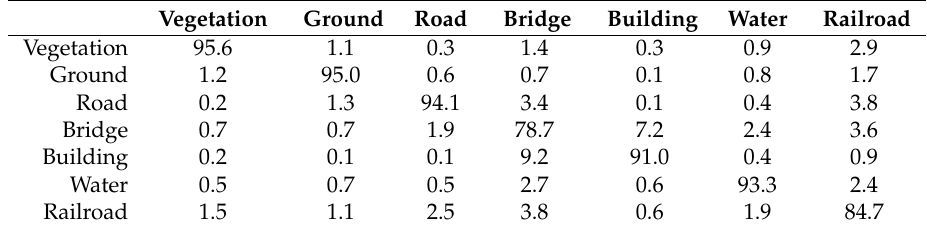
Table 2. Confusion matrix (%) for the 7 classes for a classifier trained and tested on the manually labeled data. The overall accuracy is